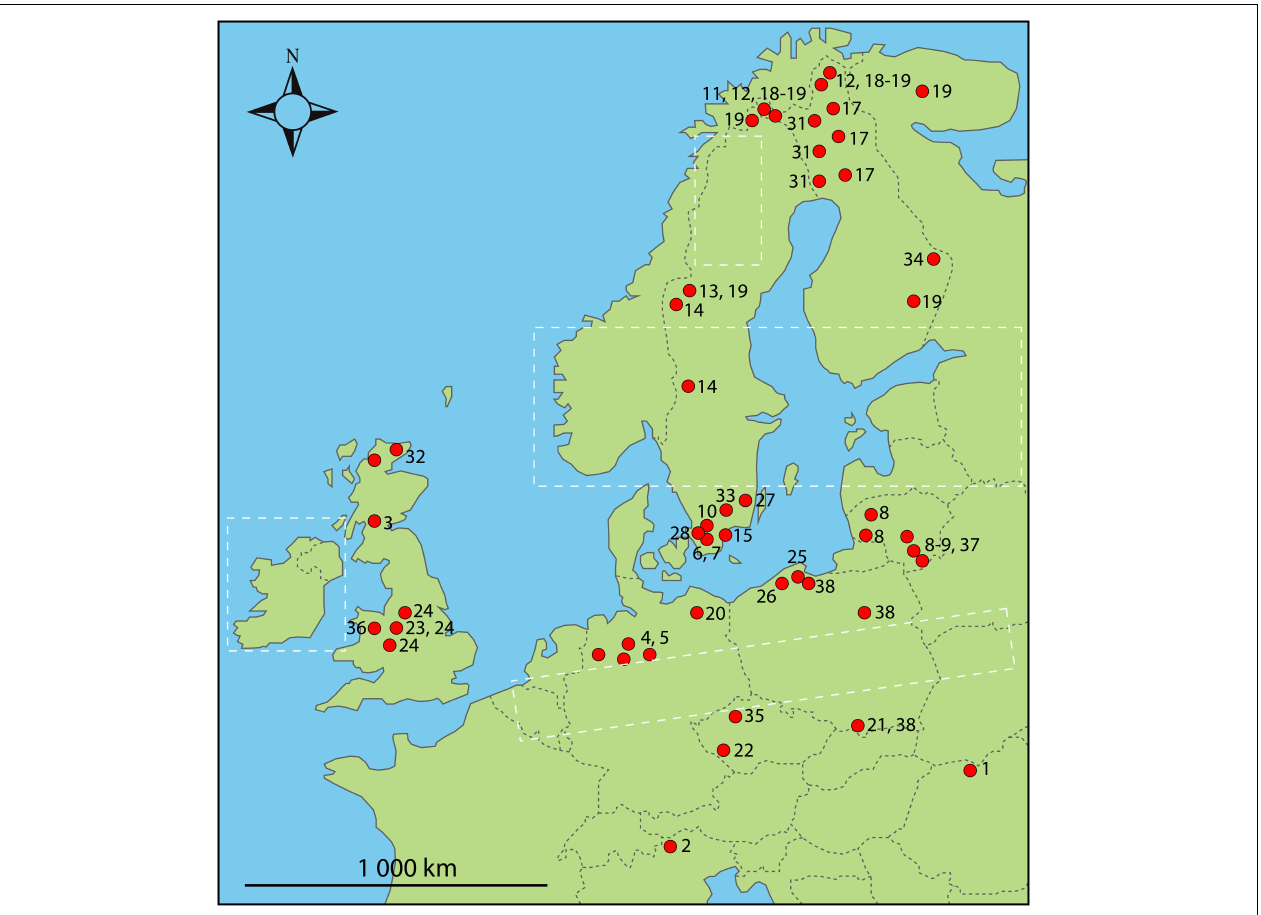
FIGURE 2 | Map showing location of the main sites presented in the articles reviewed. The numbers represent the articles presented in Table 1 . The white boxes show underutilized areas from which either dendrochronological and paleobotanical studies have been performed without being combined, or there are good opportunities for further